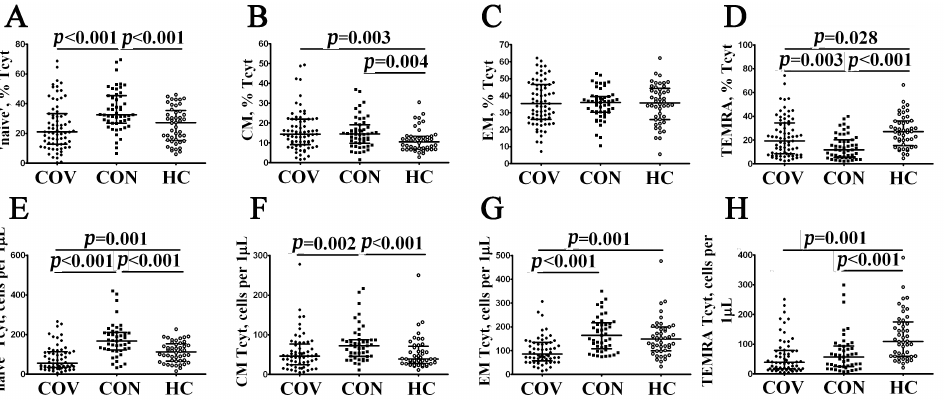
Figure 4. 4 Figure 4. Alteration in relative and absolute numbers of major CD8+ T cell subsets with varying patterns of CD45RA and CD62L expression in acute and convalescent COVID-19 patients. Scatter plots ( A – D ) and ( E – H ) show the percentages and absolute numbers of ‘naïve’ (CD45RA+CD62L+), central memory (CM, CD45RA − CD62L+), effector memory (EM, CD45RA − CD62L − ), and termi- nally differentiated CD45RA-positive effector memory (TEMRA, CD45RA+CD62L − ) CD8+ T cells, respectively. Black circles denote patients with acute COVID-19 (COV, n = 71); black squares— convalescent COVID-19 individuals (CON, n = 51); white circles—healthy control (HC, n = 46). Each dot represents individual subjects, and horizontal bars depict the group medians and quartile ranges (Med (Q25; Q75)). In Figure 4, the statistical analysis was performed with the Mann–Whitney U